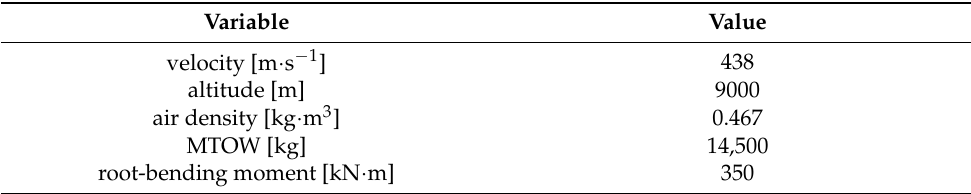
Table 2. Definition of computational